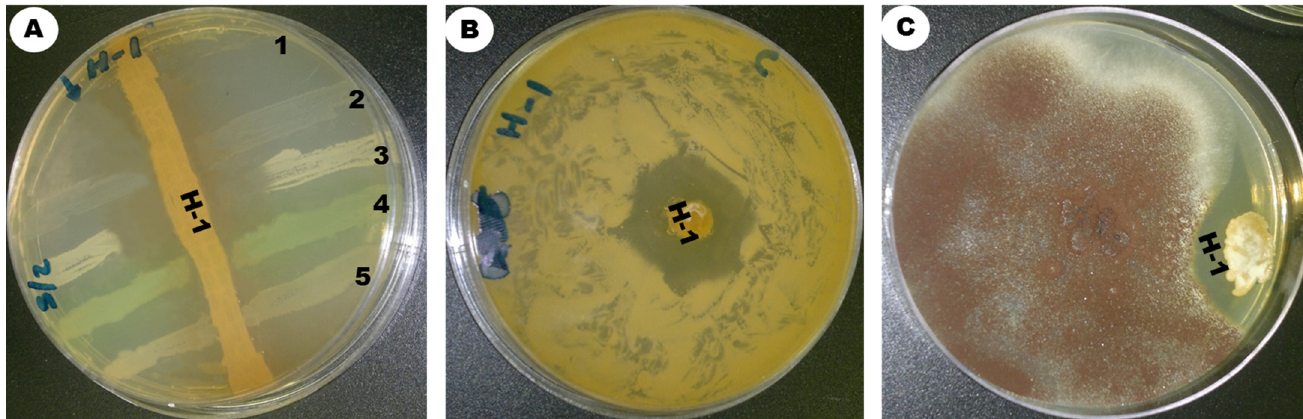
Figure 1. Preliminary screening of potential strain by antimicrobial activity. ( A ) Antibacterial activity toward (1) S. aureus , (2) S. typhi, (3) S. pneumoniae, (4) P. aeruginosa , and (5) K. pneumoniae . ( B ) C. albicans . ( C ) Aspergillus niger.